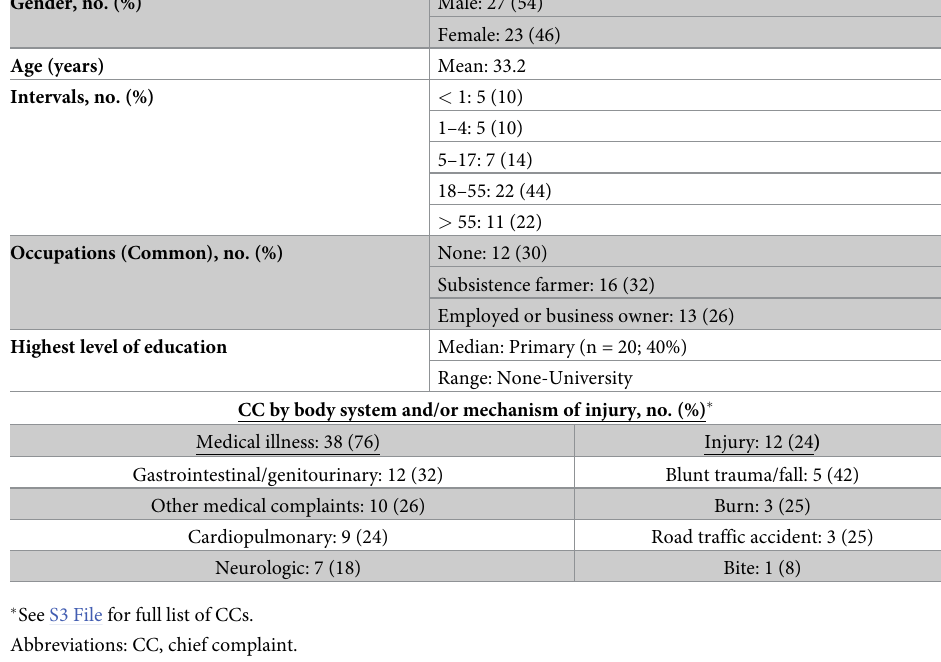
Table 1. Patients’ demographic data and